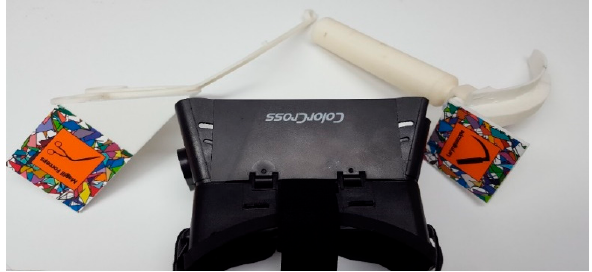
Figure 6. Three-dimensional printed tools with AR image targets, including a ColorCross head mount for mobile phone simulation [12].